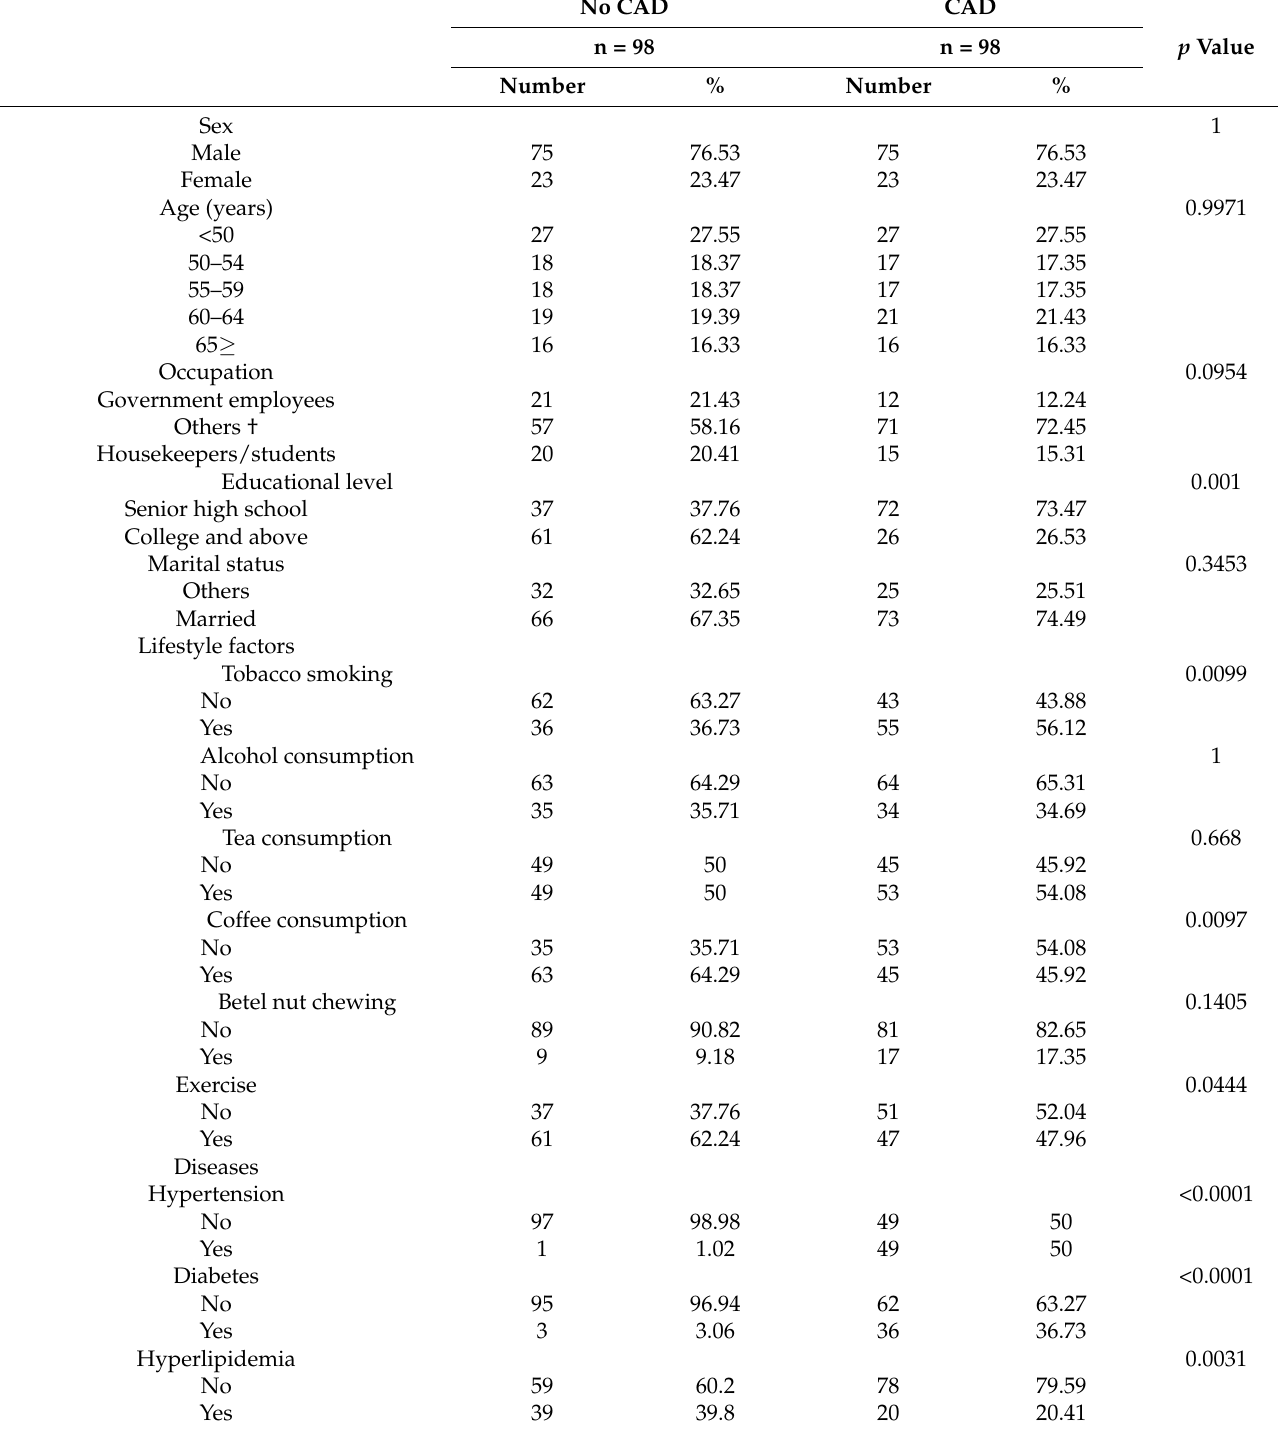
Table 1. Characteristics of study